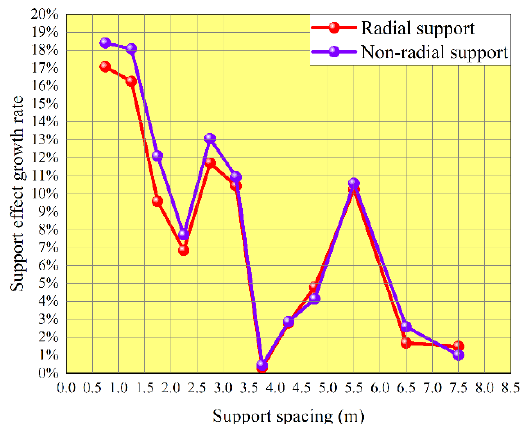
Figure 15. Support effect growth rate of the support face under the two support schemes.